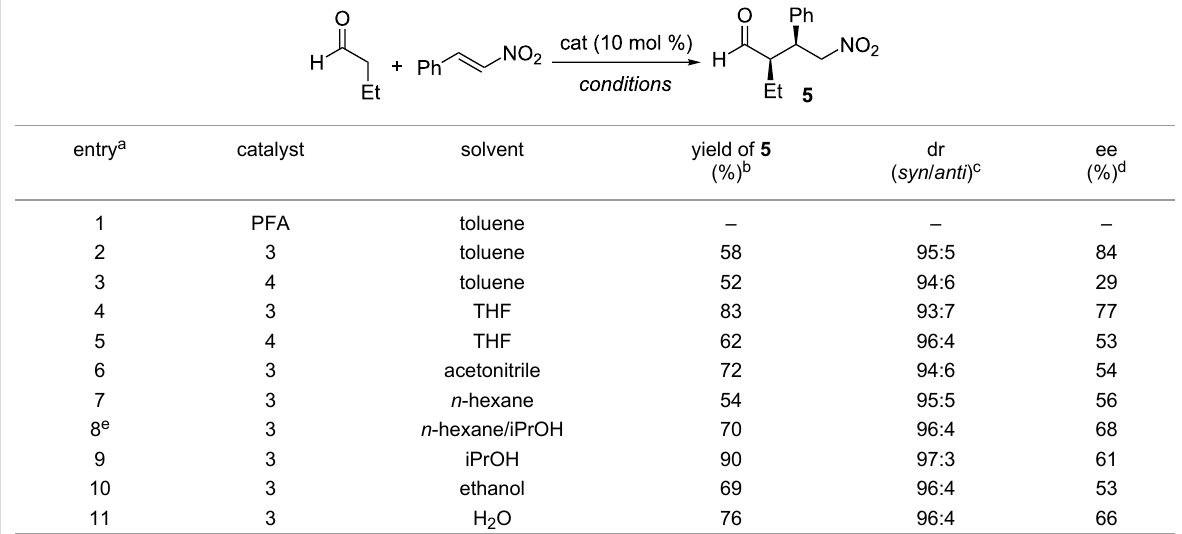
Table 1: Screening of PFA-supported prolyl pseudo-peptide catalysts and the reaction conditions in a batch heterogeneous Michael addition.